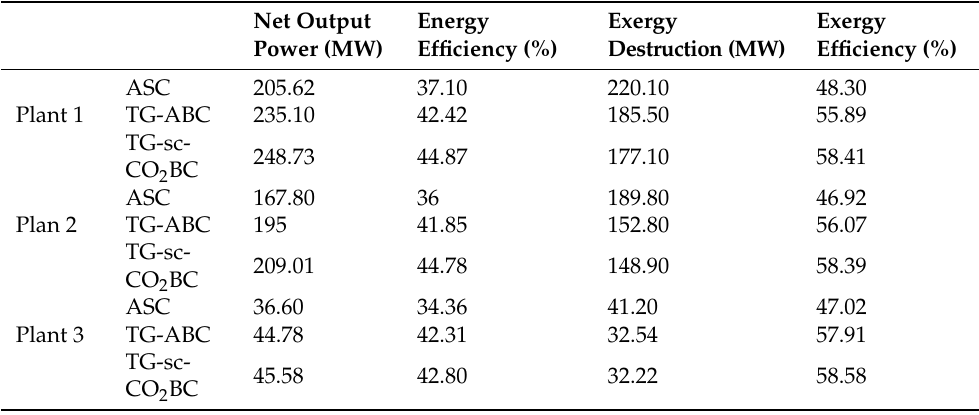
Table 13. Net output power, energy and exergy efficiencies, and exergy destruction for the different plants with the three cycles based on optimum pressure rate.